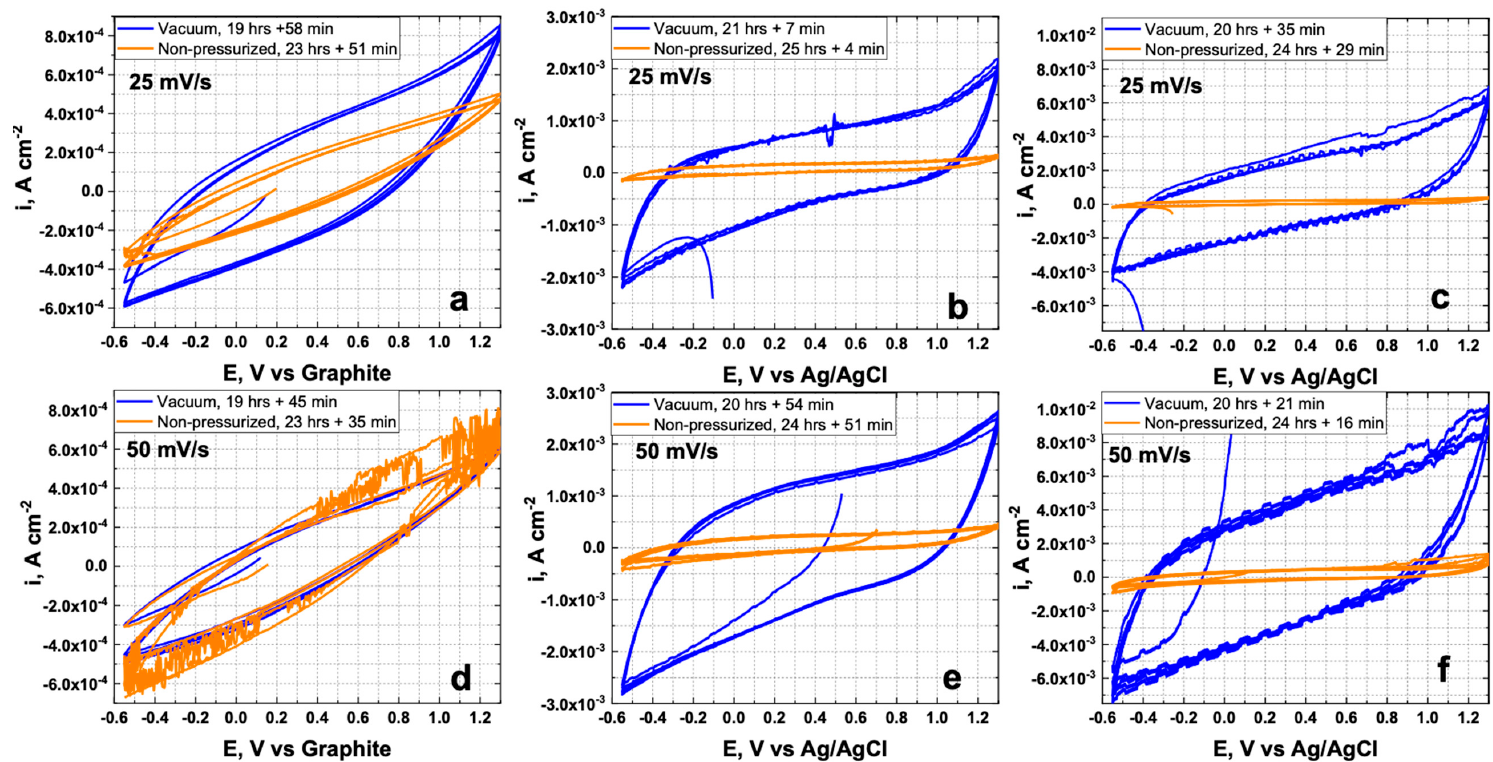
Figure 4. S 1: Electrochemical behavior of the MFC at different sweep potentials on cathode direction and under vacuum and non-pressurized conditions. The anode chamber was filled up with distilled water and the cathode chamber with a hydrochloric acid solution (0.1 M HCl, pH ≈ 1.8). It is also seen that ( a ) and ( d ) ( b ), and ( e ) and ( c ) and ( f ) were obtained with the potentiostat settings A, B and C, respectively (Figure 2).